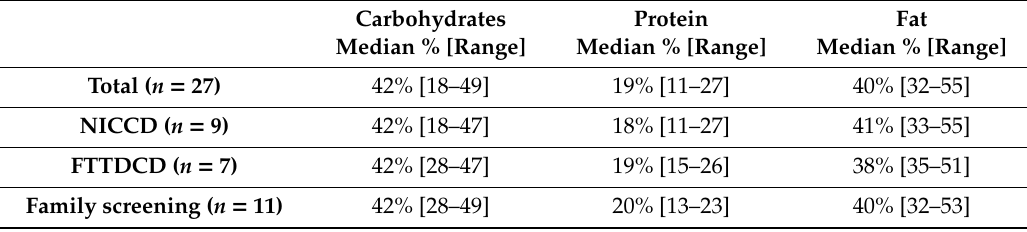
Table 6. Median percentage of energy contribution from protein, fat and CHO calculated from dietary assessments.